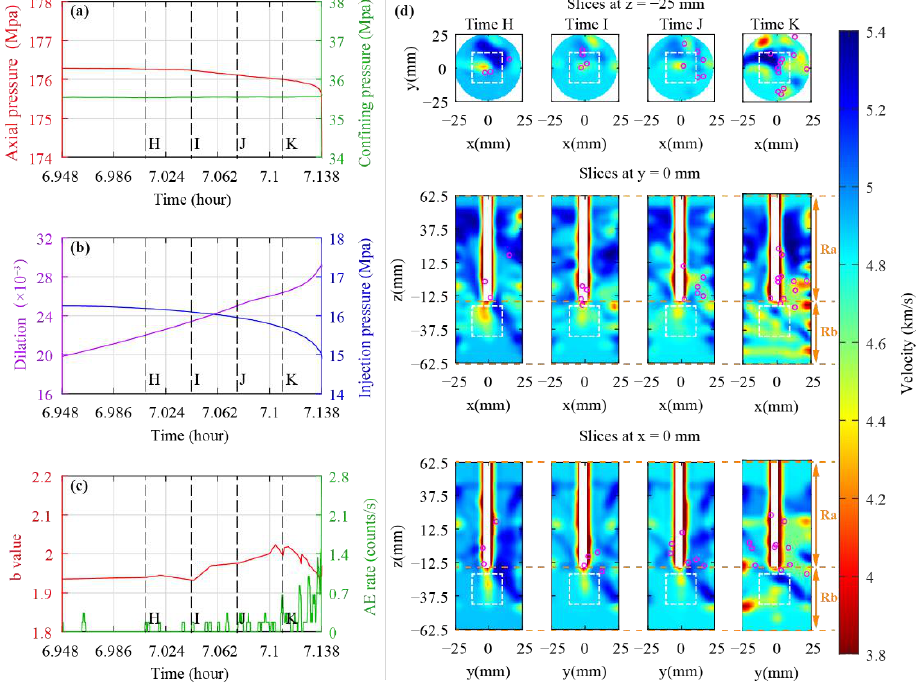
Figure 11. Mechanical response and velocity images of rock after water injection pressure reached peak value in H1 phase: ( a ) axial (red line) and confining pressure (green line); ( b ) dilation (purple line) and water injection pressure (blue line); ( c ) b-value (red line) and AE rate (green line); ( d ) slices of the 3D ultrasonic velocity images at different times (Times H~K, respectively, correspond to the times marked by the black dotted lines in the left subfigures, and the magenta circles represent the positions of acoustic emission events occurring before the corresponding times). The orange dotted line in the subfigure ( d ) represents the boundary between region Ra and Rb. The white dotted line box represents the low-velocity zone below the